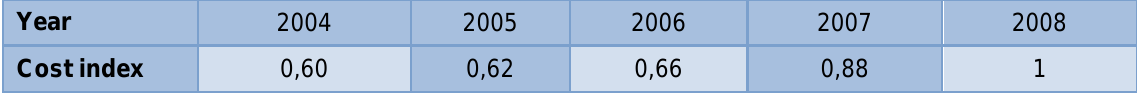
Table 1 Construction cost index value in the West